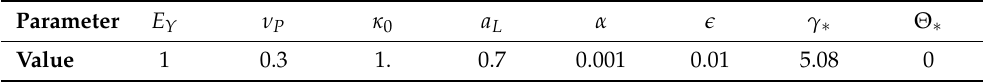
Table 4. List of the non-dimensional parameters for Sections 4.3 and 4.4.